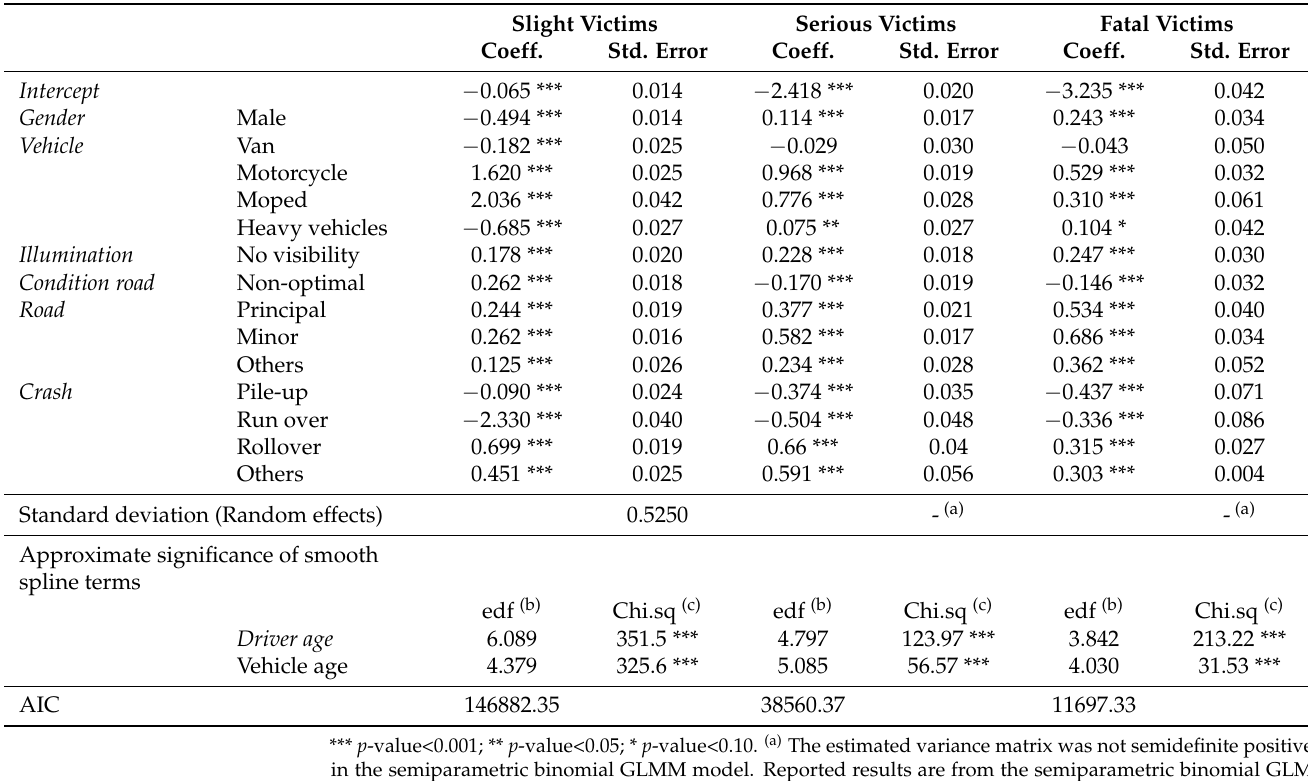
Table A2. Coefficient estimates according to BI severity of